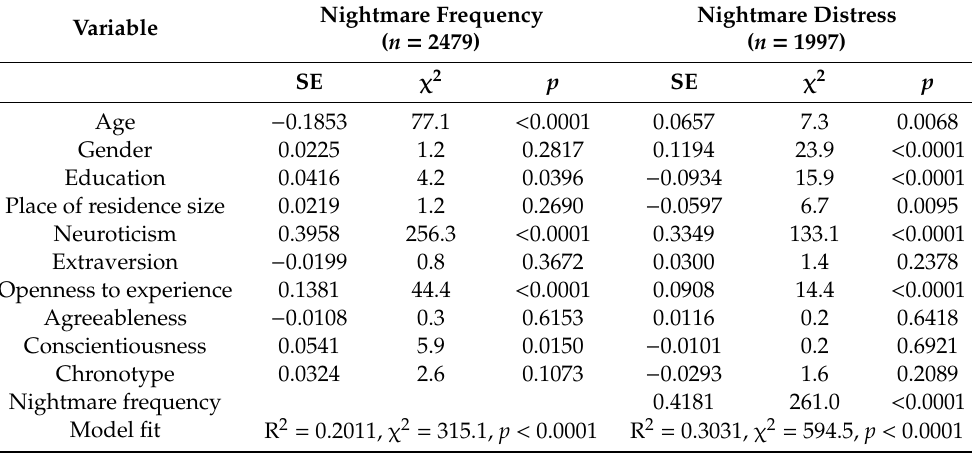
Table 7. Ordinal regressions for nightmare frequency and nightmare